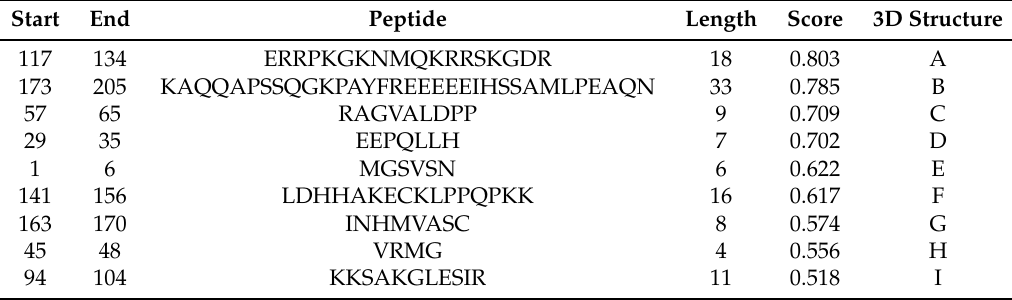
Table 6. Predicted discontinuous antigenic epitopes of the cLin-28